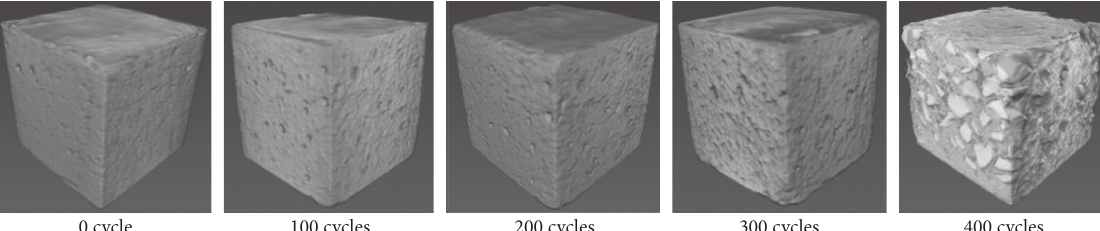
Figure 13: Profile of 10% CaO expansive concrete (C-10) under different freeze-thaw cycles.